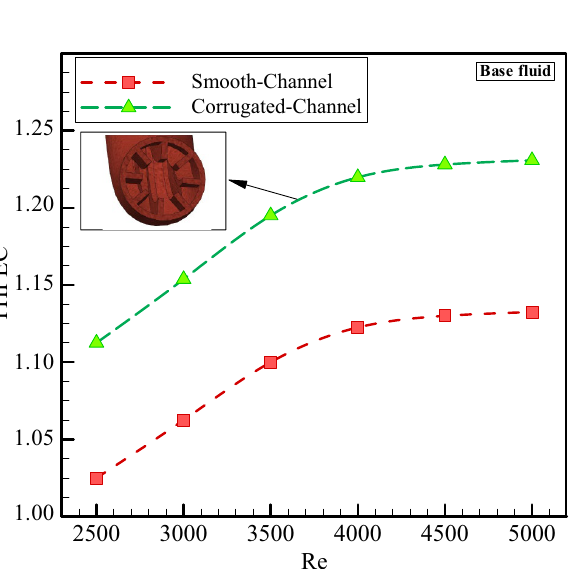
Figure 10. Geometrical effects on THPEC variation versus Re in helical heat exchanger filled with base